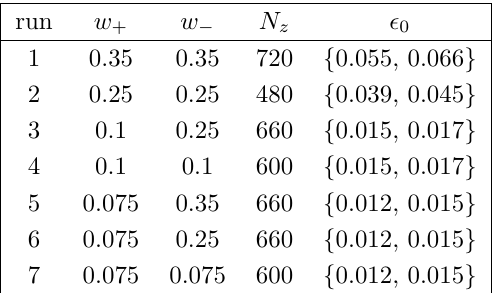
is in units of 0 p = 2 (cid:25) . Computed results at the two listed +